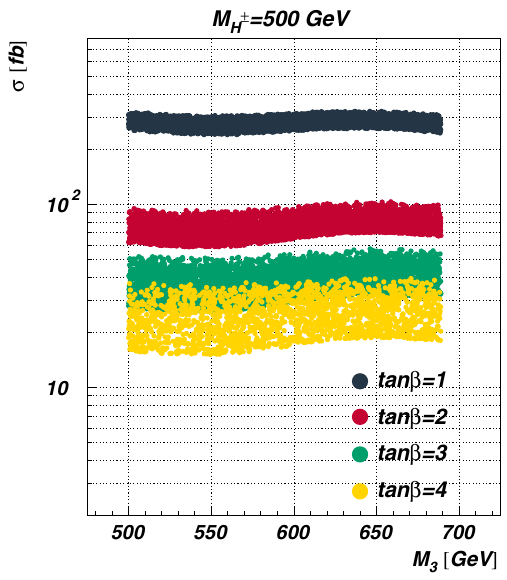
Fig. 16 Charged Higgs bosonic production cross sections in the 2HDM, Model II, for 14 TeV, and a fixed value of M H ± = 500 GeV, plotted vs. M 3 ≡ M A for tan β = 1, 2, 3 and 4